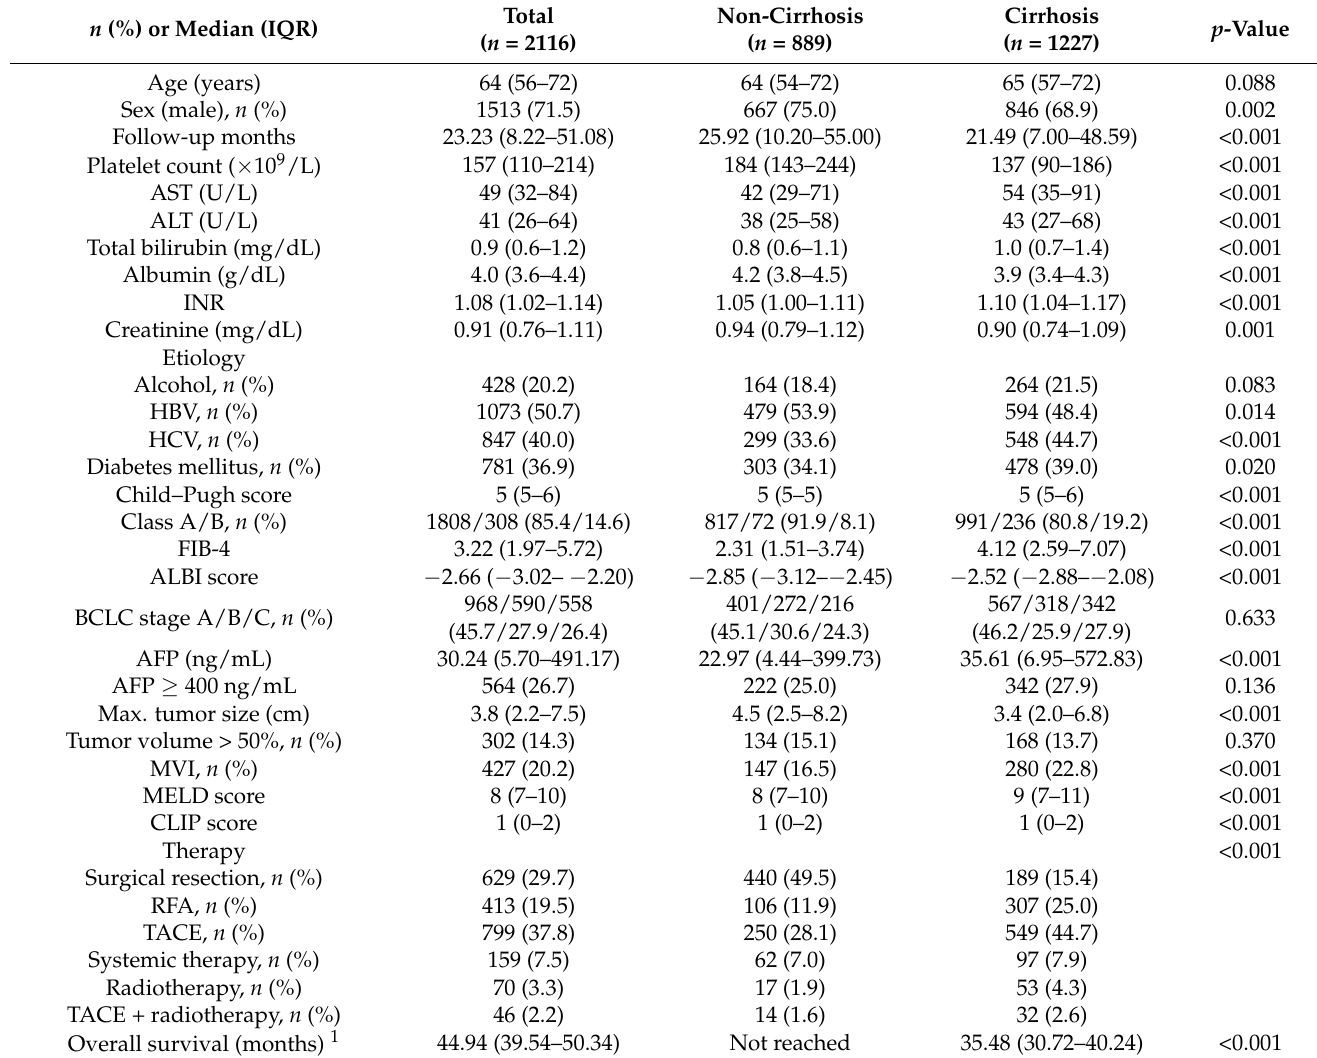
Table 1. Patient demographics, baseline characteristics, and